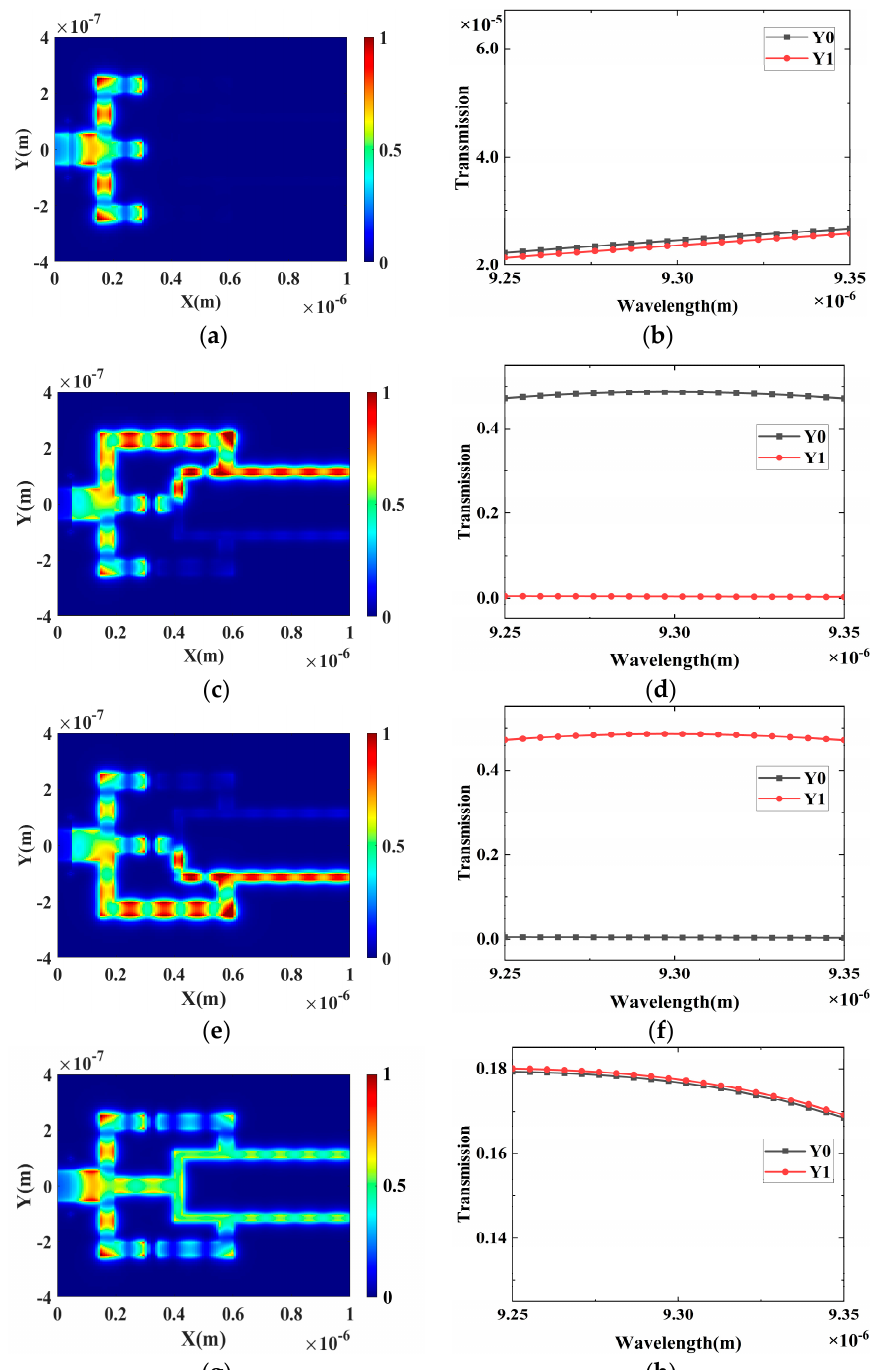
Figure 7. Electric field distribution of the proposed 4×2 encoder under different conditions: ( a ) I0 = 1 and I1 = I2 = I3 = 0, ( c ) I1 = 1 and I0 = I2 = I3 = 0, ( e ) I2 = 1 and I0 = I1 = I3 = 0, ( g ) I3 = 1 and I0 = I1 = I2 = 0, and their corresponding wavelengths as a function of the transmission spectrum at the output ( b ) Y0 = 0,Y1 = 0, ( d ) Y0 = 1,Y1 = 0, ( f ) Y0 = 1,Y1 = 0, and ( h ) Y0 = 1,Y1 = 1. Table 2. Truth table of the proposed 4×2 encoder .